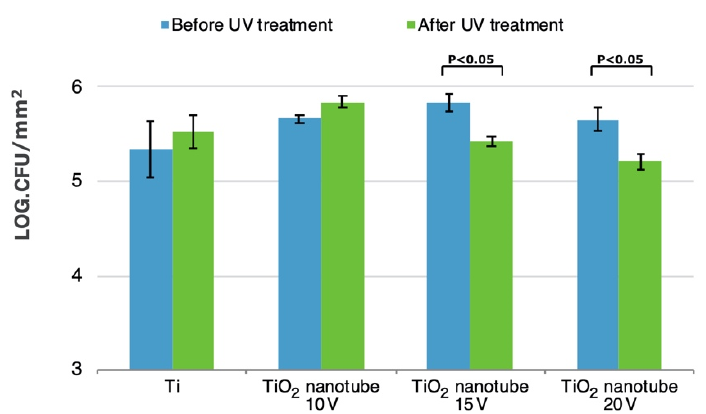
Figure 2. The amount of adhered S. mutans on the experimental specimens before and after UV treatment. Data are presented as mean ± standard deviation ( n = 3). UV treatment caused statistically significant decreases in bacterial adhesion only for 15 V and 20 V TiO 2 nanotubes.